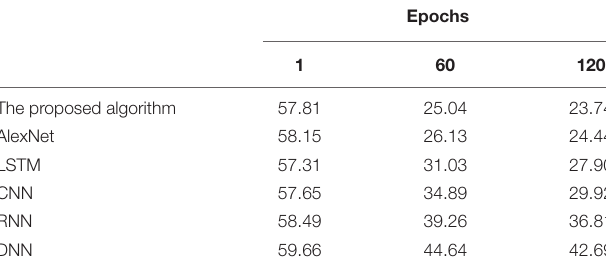
TABLE 2 | Time duration required by different algorithms on the test